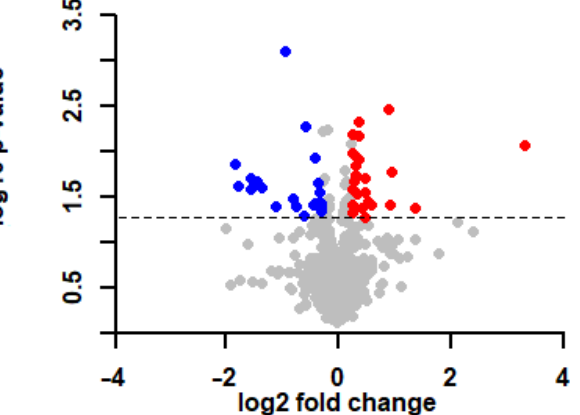
Figure 1. Diet-induced hypercholesterolemia leads to alterations in the myocardial proteome. Volcano plot showing the significantly ( p < 0.05 of Welch’s t -test, 1.2< and <0.83-fold changes) altered proteins induced by hypercholesterolemia in the left ventricles of rats. Each dot represents one dis- tinct protein. The downregulated (blue) and upregulated (red) proteins are highlighted in the plot. The dashed line indicates the threshold value of significance ( − log 10 1.3<) The differentially ex- pressed proteins are listed in Table 3. Table 3. List of hypercholesterolemia-induced significant alterations in the left ventricular proteins. Proteins with fold changes of >1.2 or <0.83 were considered as significant. The fold change values are shown as ratio pairs. UniProt ID